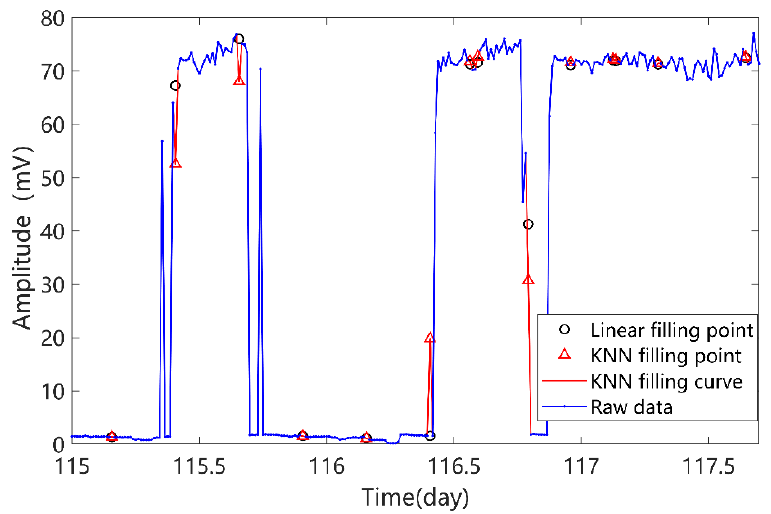
Figure 6. Missing filling of measurement data of pulse current sensor by KNN algorithm.